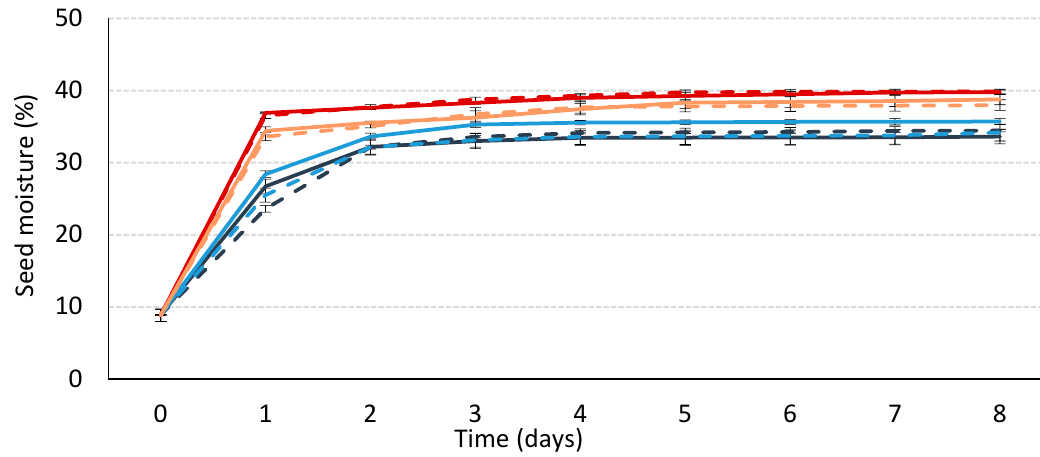
Figure 4. The seed moisture content (%) along the soaking period. Mean values for the combinations of two caper seed lots (owned seeds in blue lines and standard seeds in red lines), two imbibition mediums (between the paper in dark lines and in a 10 cm column in light lines), and two substrate saturation solutions (water in continuous lines and the GA solution in dashed lines). Vertical bars represent the standard error.